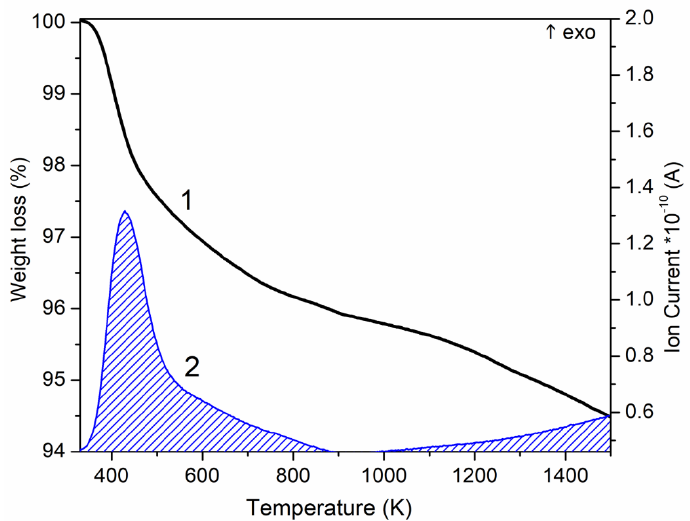
Figure 7. Thermal analysis of the HA powder: 1 — weight loss; 2 — evolved water (from [13]).